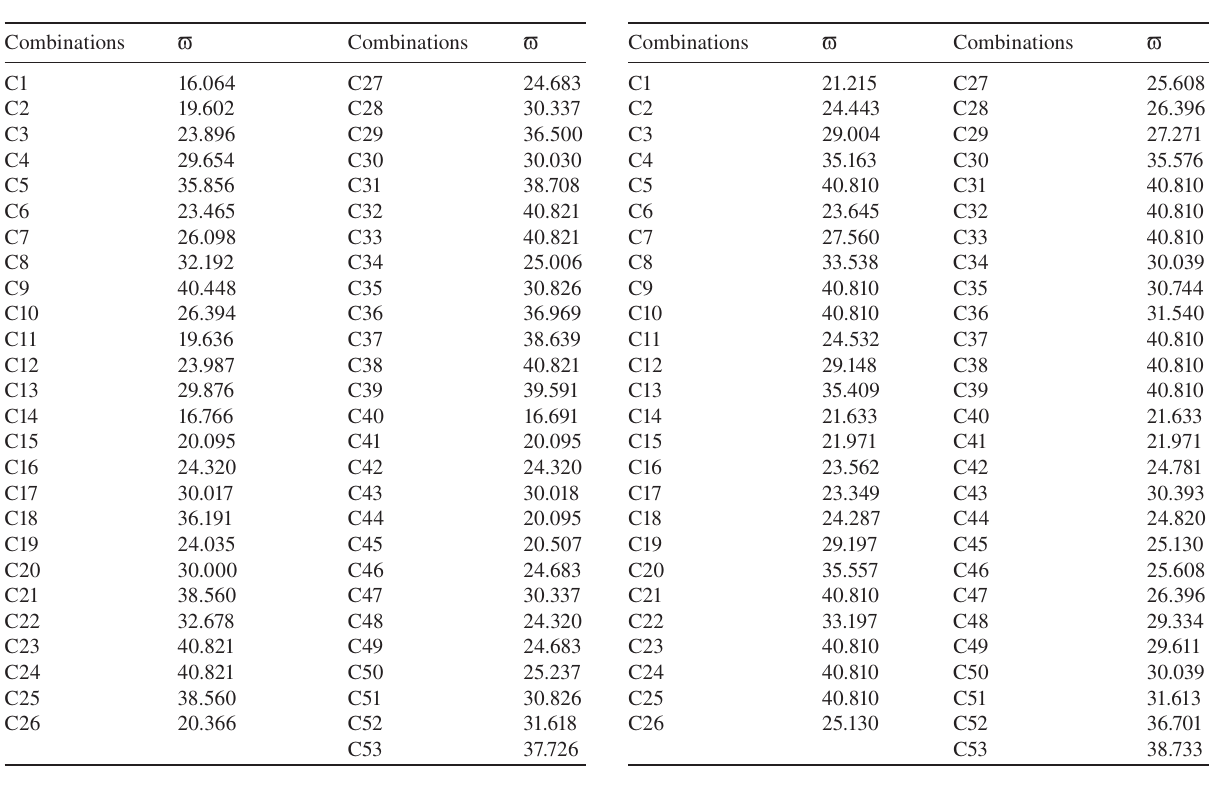
Table 5 Fundamental frequency parameter for laminated plates with intermediate line supports for ( CSCS ) boundary condition.